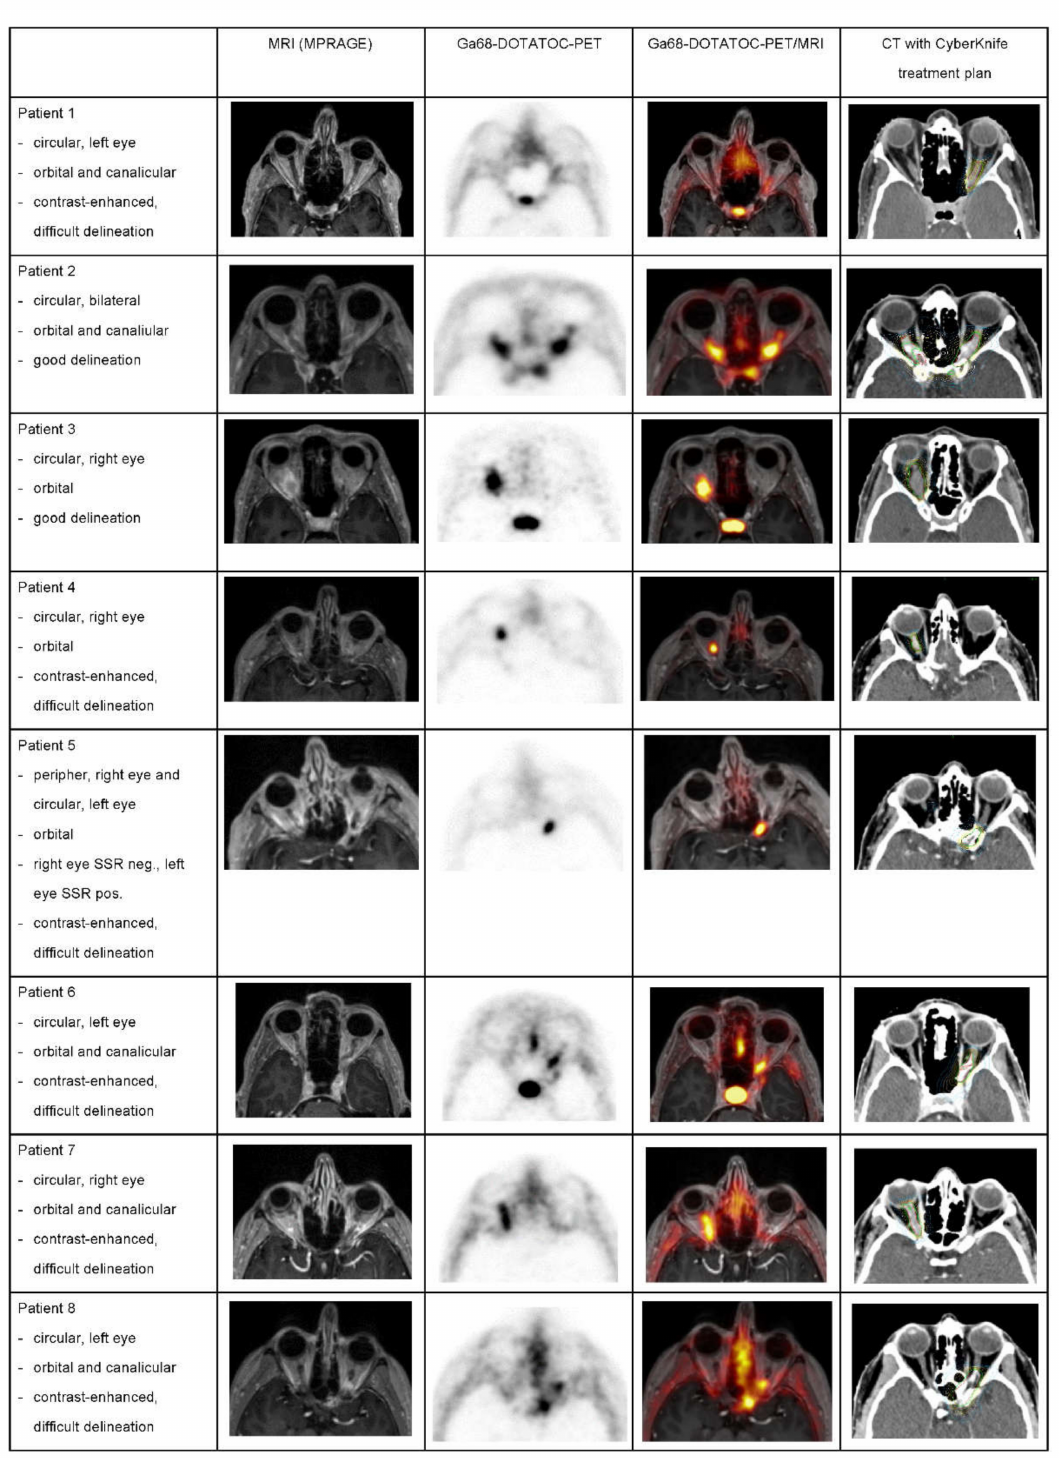
Figure 2. Optic nerve sheath meningiomas (ONSM) on MRI and PET images in all patients and according to the treatment plan. In patients with bilateral ONSM, only one side is presented. MRI, magnetic resonance imaging, PET, positron emission tomography; MPRAGE, contrast-enhanced T1-weighted magnetization-prepared rapid acquisition with gradient echo; Ga68-DOTATOC, gallium-68-labeled (DOTA0-Phe1-Tyr3) octreotide; SSR, somatostatin receptor; Neg, negative; Pos,